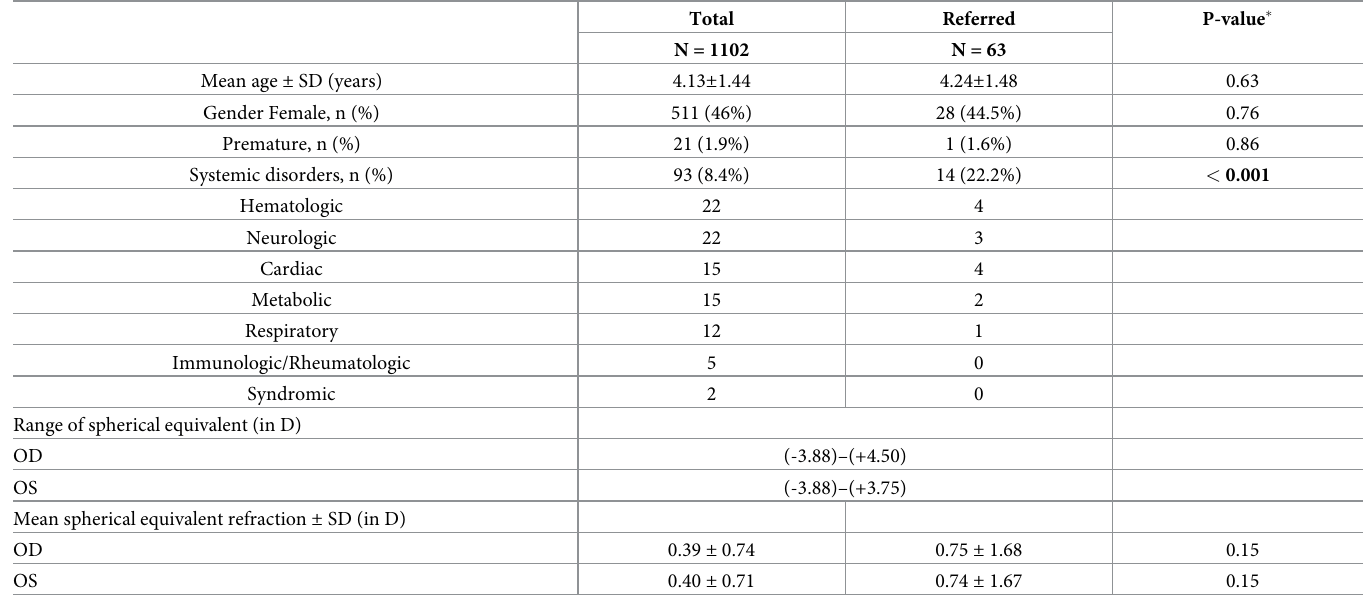
Table 2. Demographics of the studied population compared to the demographics of the population subgroup requiring referral to a comprehensive eye